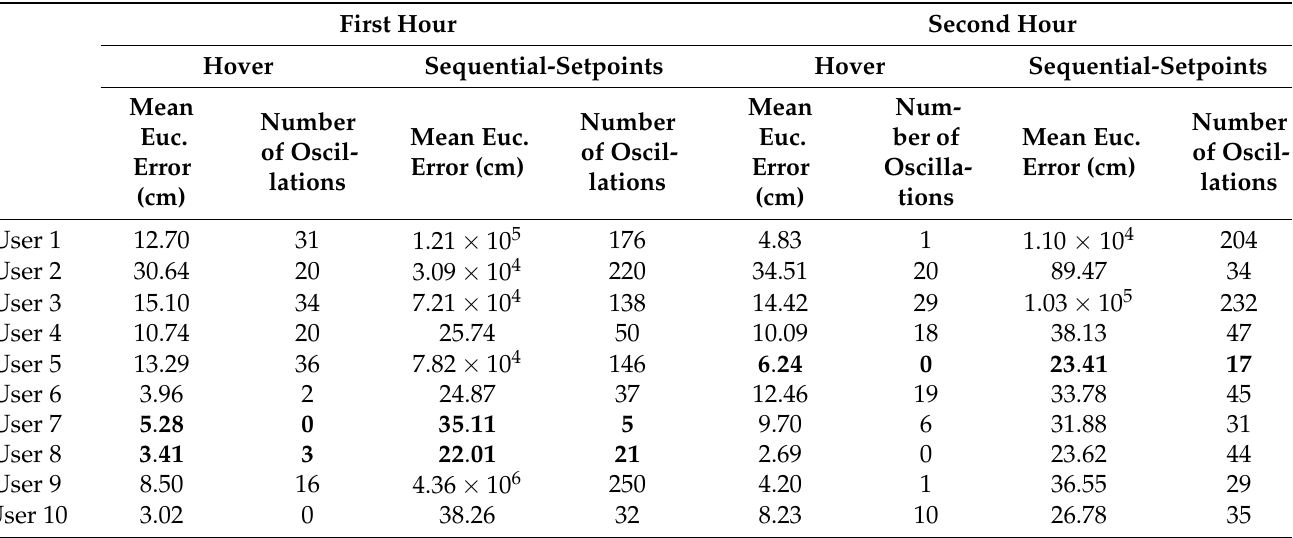
Table 6. Mean Euclidean error and the corresponding oscillatory response for the weight sets obtained by user-based tuning. Accordingly, the weight sets whose results are marked with bold font are regarded as real flight-worthy. First Hour Second Hour Sequential-Setpoints Hover